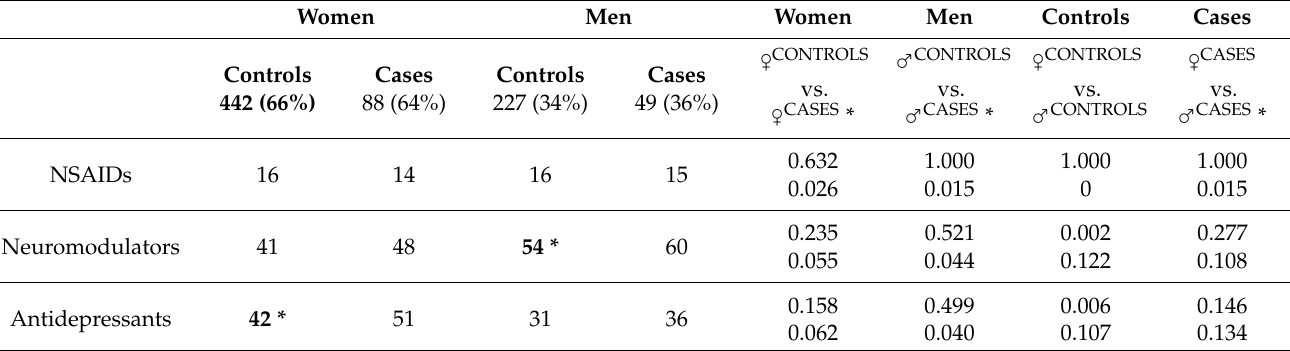
Table 4. Pharmacological and health use analysis by